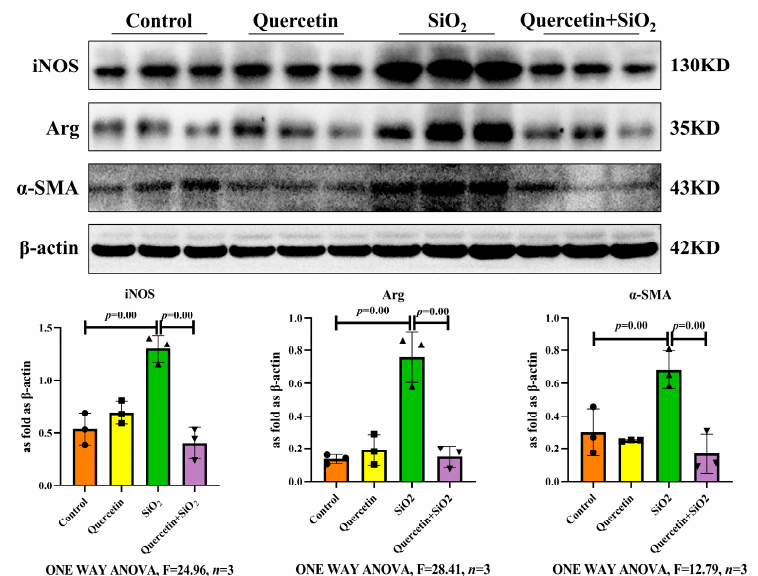
Figure 9. The expressions of iNOS, Arg, and α -SMA in SiO 2 -treated MH-S cells, measured by West- ern blot. Data are presented as the mean ± SD, n = 3 per group.